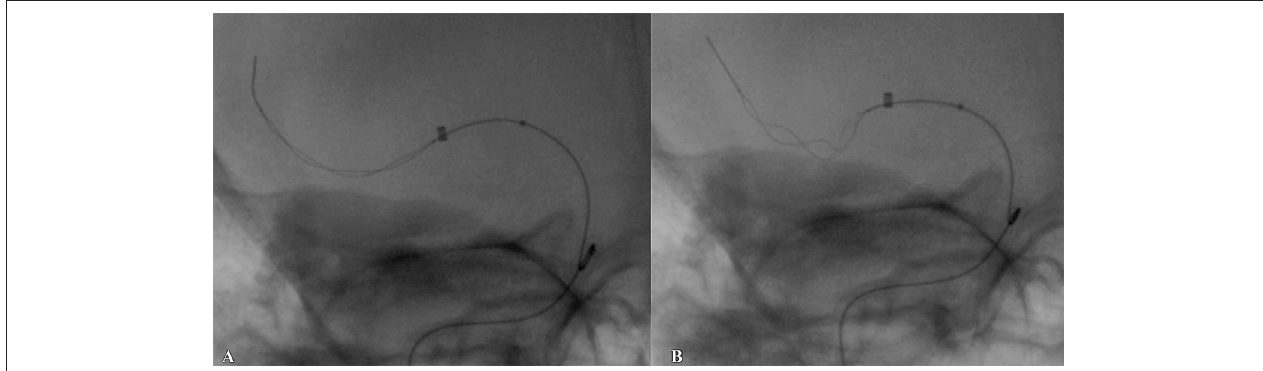
FIGURE 2 | Native (unsubtracted) images of Tigertriever behavior during retrieval attempt. (A) Stent deployment at occlusion site, (B) improved expansion using repetitive inflation–deflation technique, stent retriever position during retraction with a bow-tie configuration of the stent mesh, which gives a highly improved vessel wall